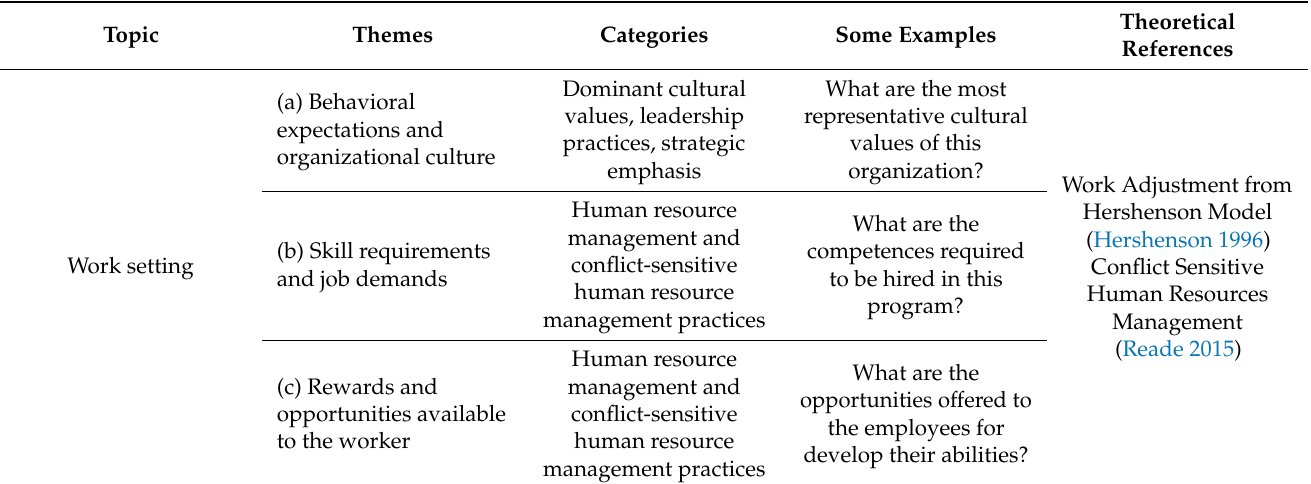
Table 2. Topics, themes, and theoretical